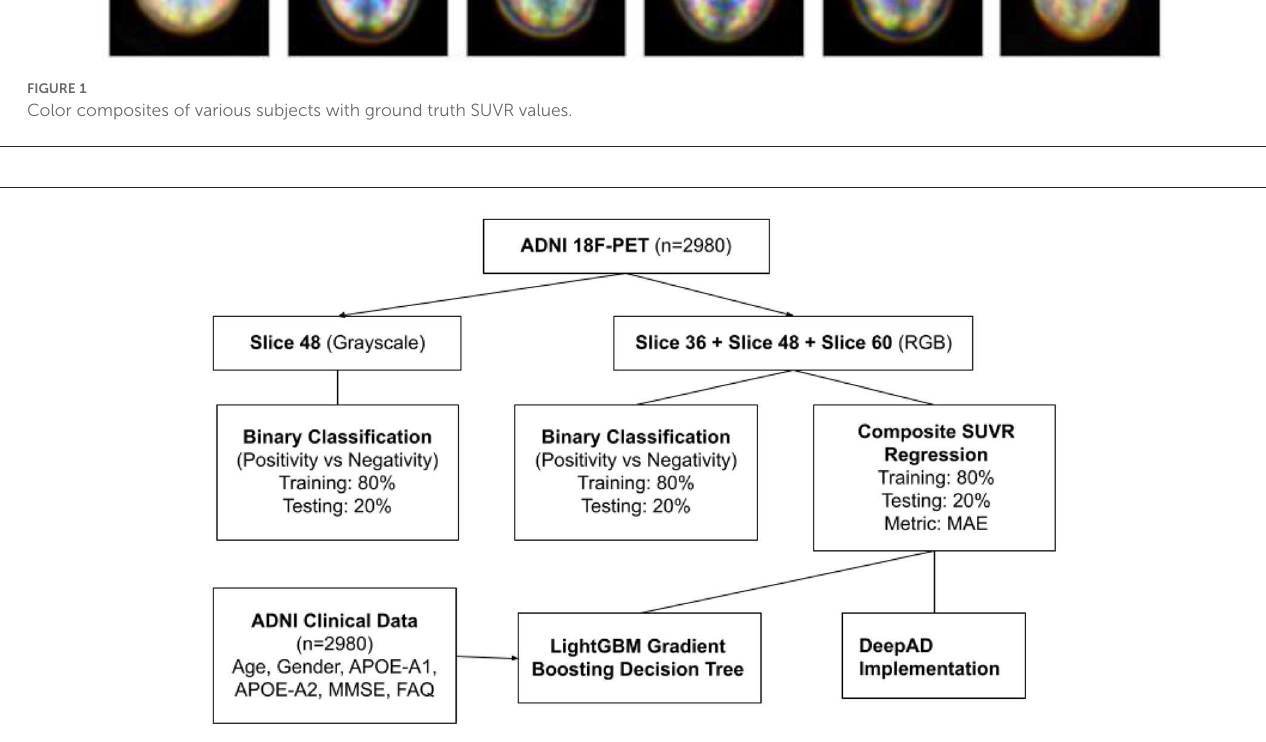
FIGURE2 Flowchart of ADNI data